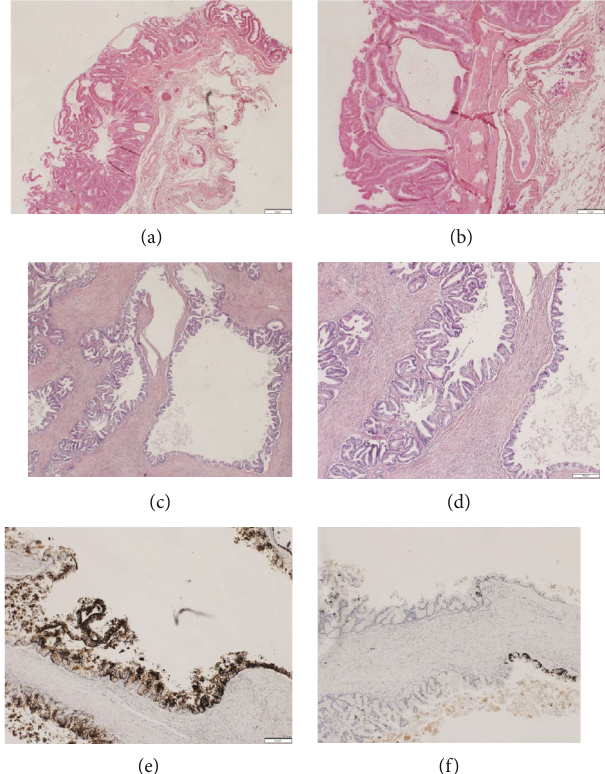
Figure 6: (a, b) Gallbladder with foci of epithelial dysplasia and carcinoma in situ. (c – f) Epithelial neoplastic proliferation composed of cystic structures lined by a layer of columnar or cubic cells, with formation of micropapillae and mild-moderate atypia. In the immunohistochemical study, these cells express CK7 di ff usely and CK20